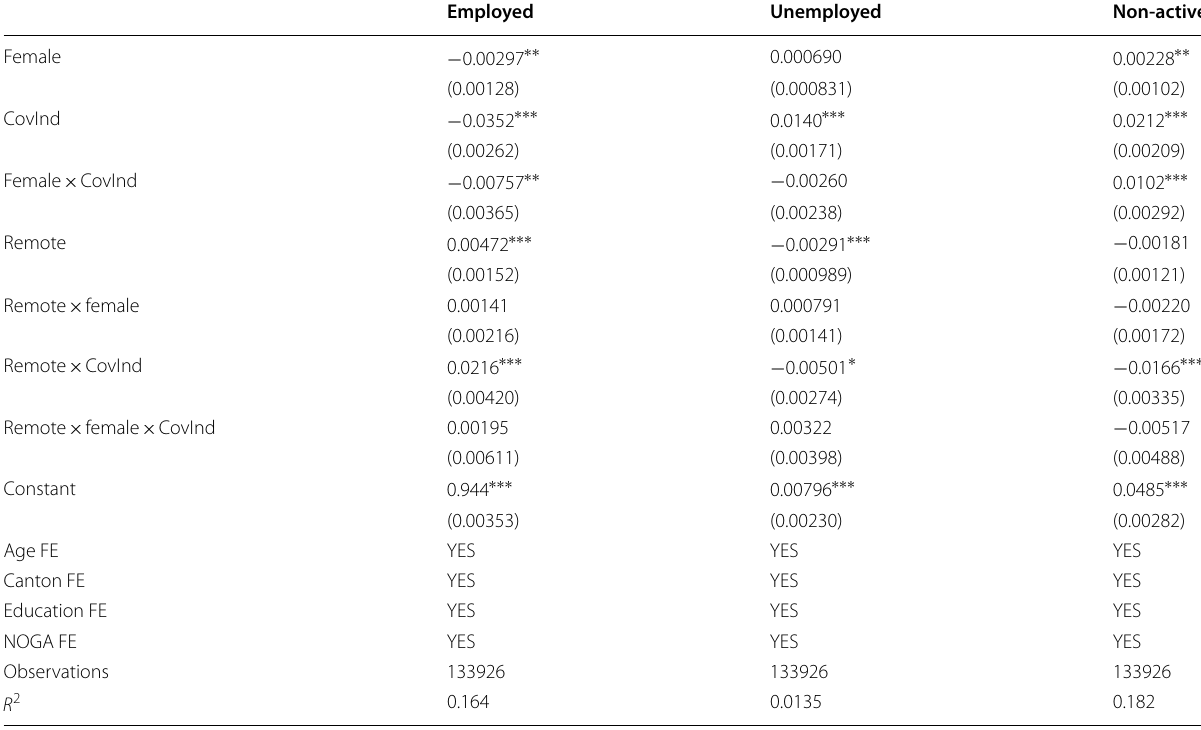
We show estimates from regression (2) of labor market status on a constant, female dummy (1 for women and 0 otherwise), COVID-19 stringency index, remote dummy (1 for respondents who can perform remote working occasionally or regularly and 0 otherwise), and their interactions. Regressions estimated with linear probability model, including random effects. Robust standard errors in